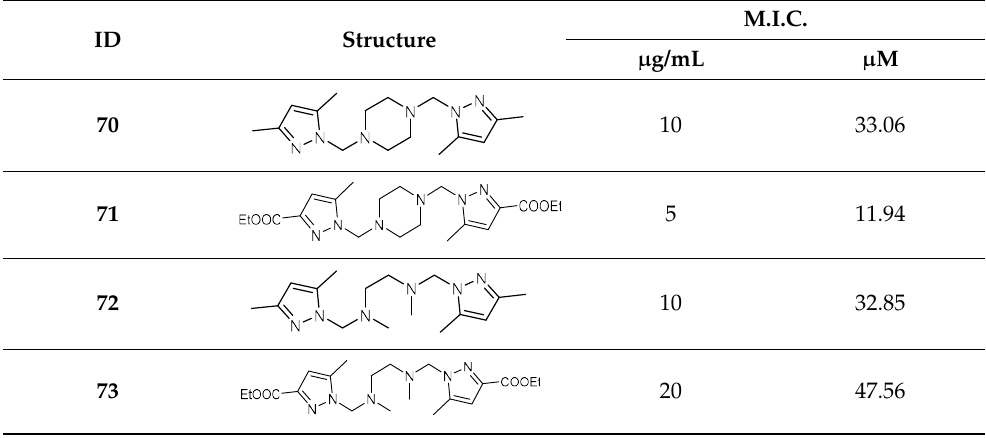
Table 9. M.I.C. values of N , N (cid:48) -bipyrazole piperazine derivatives tested against F.o.a. Table 9. M.I.C. values of N , N ′-bipyrazole piperazine derivatives tested against F.o.a. Table 9. M.I.C. values of N , N ′-bipyrazole piperazine derivatives tested against F.o.a. Table 9. M.I.C. values of N , N ′-bipyrazole piperazine derivatives tested against F.o.a. Table 9. M.I.C. values of N , N ′-bipyrazole piperazine derivatives tested against F.o.a.